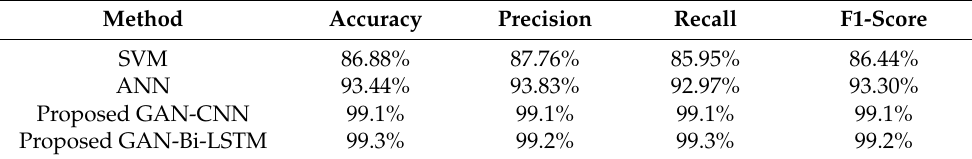
Table 8. Benchmarking the proposed models against ML and DL models for the Cleveland dataset.